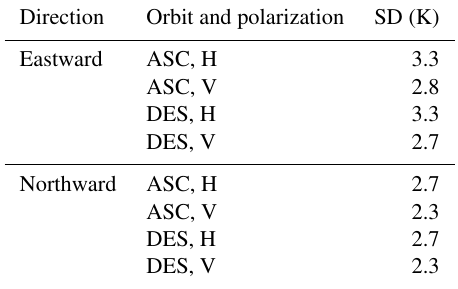
Table 4. Eastward and northward components of standard deviation of T B images in the subregion of the central Weddell Sea buoy from July 2018, corresponding to the time the buoy resided within the black box (Fig. 6). Satellite orbits and polarizations are ASC hori- zontal (ASC, H), ASC vertical (ASC, V), DES horizontal (DES, H), and DES vertical (DES,